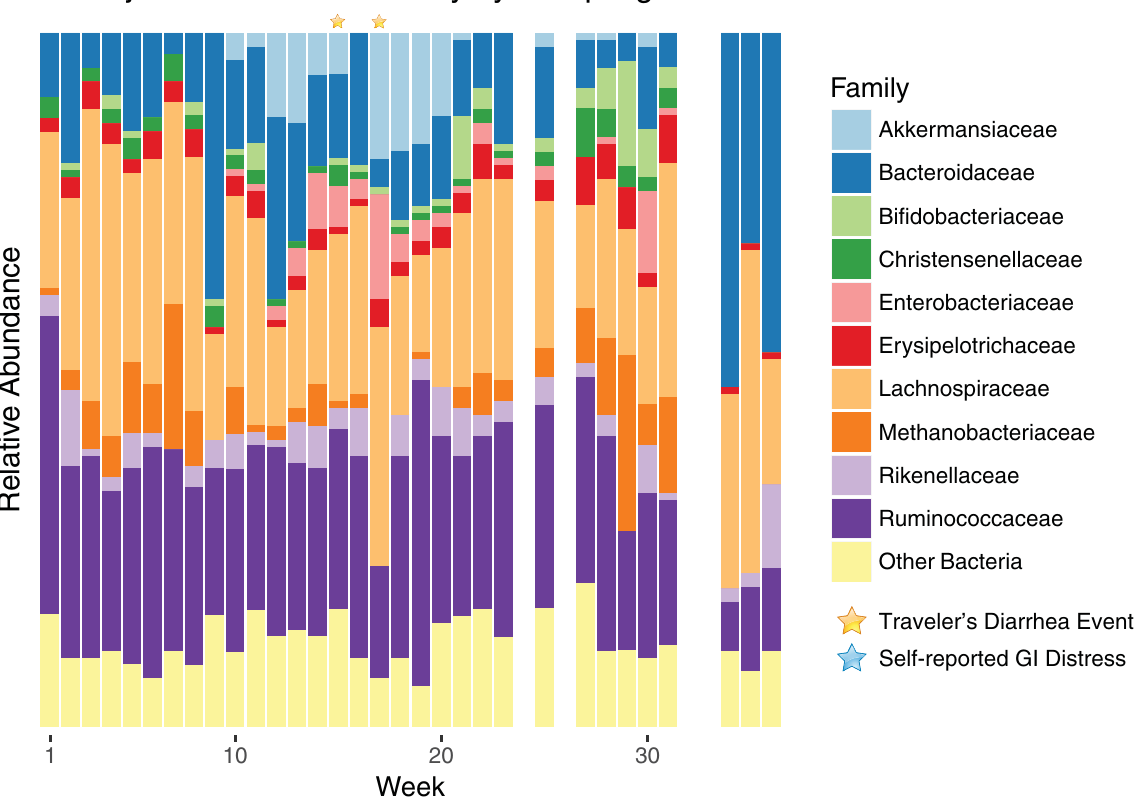
Fig 4. Family level taxa over time for Subject 33. Shifts in family-level taxa for subject 33, who experienced multiple episodes of TD. Taxa are shown from the ten most abundant families for this subject, with the remaining bacteria collapsed into a single category.